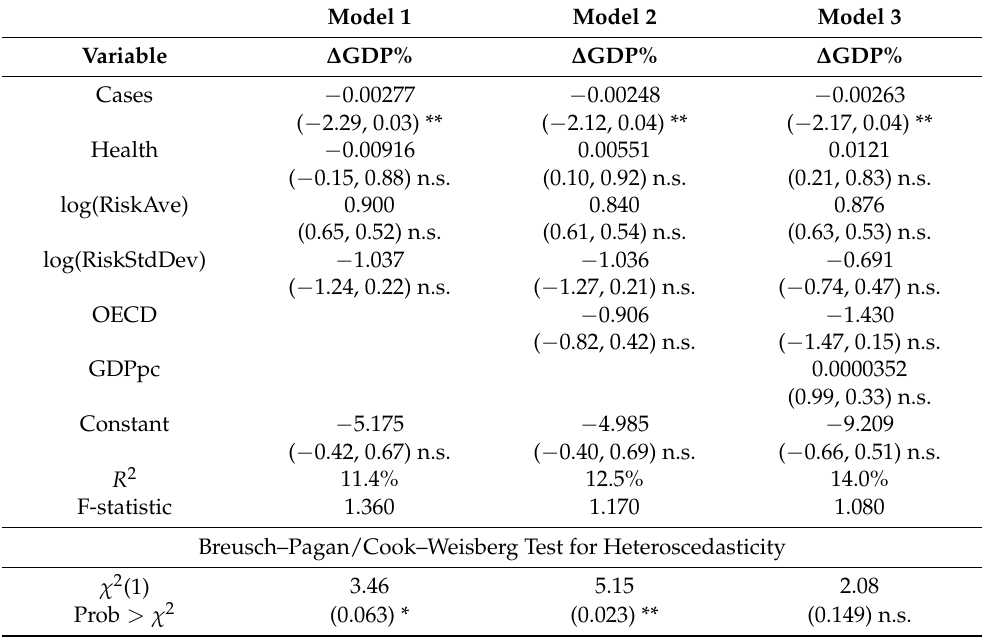
Table 4. Parameter estimate, ( t -statistic, p -value, with its significance in parenthesis), and indicators of the listed model with COVID-19 economic data without considering